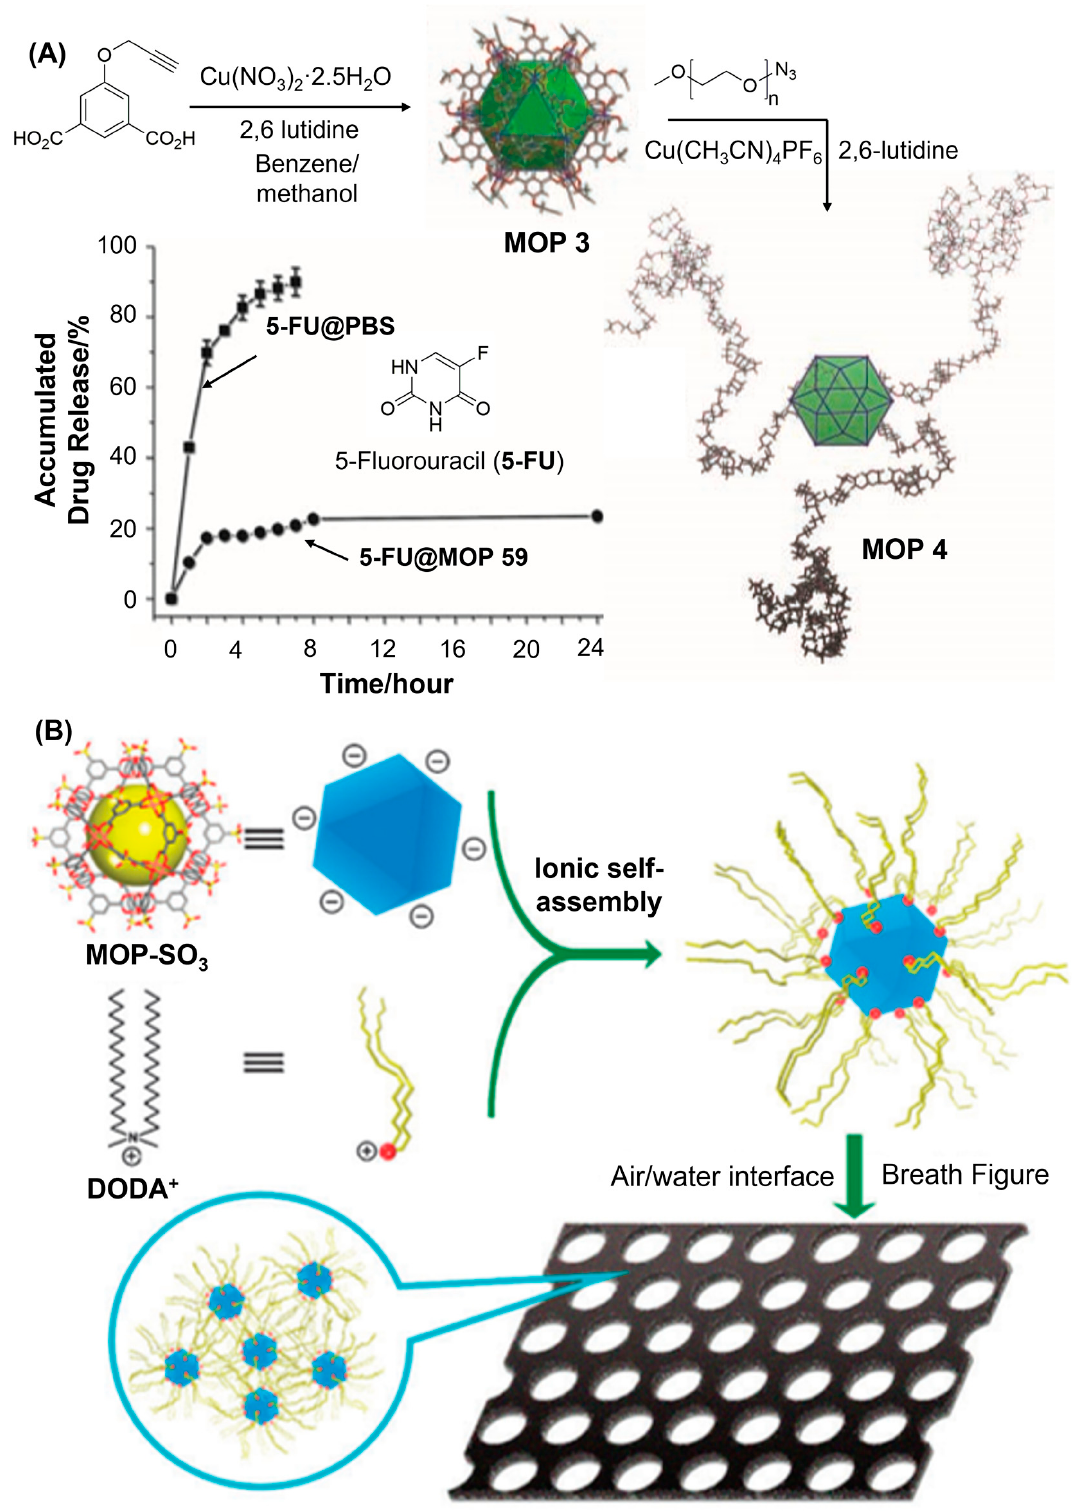
Figure 6. ( A ) Synthesis of copper (II) containing cuboctahedron MOP 3 and its post-synthetic modification with PEG to give water-soluble and stable MOP 4, and its role in controlled release of 5-fluorouracil (5-FU) drug. ( B ) Illustration of surface functionalized MOP-SO 3 via ionic self-assembly (ISA) and their ordered honeycomb architectures at the air/water interface. Reprinted by permission from Refs. [74,99]. Copyright 2011 from Wiley-VCH and copyright 2012 from Royal Society of Chemistry.